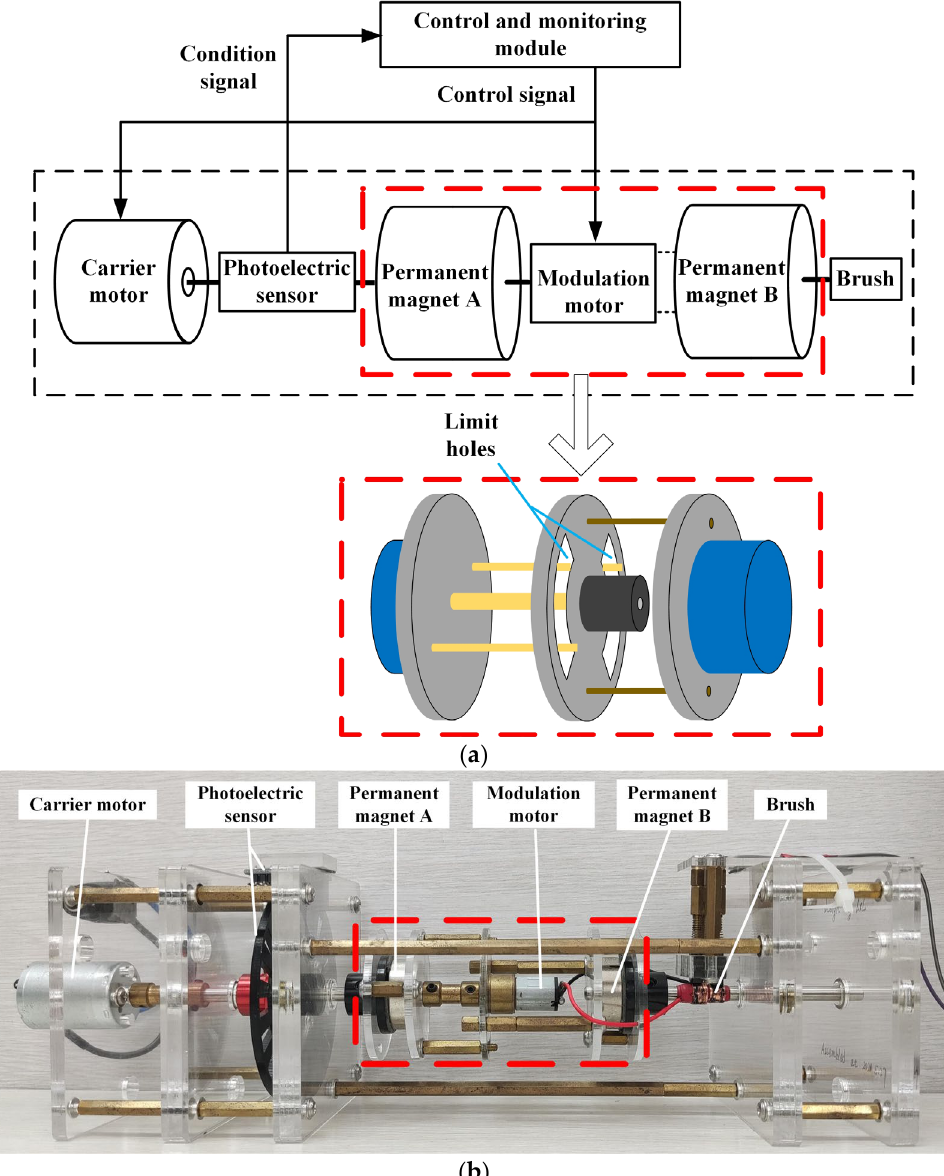
Figure 5. Dual-permanent-magnet mechanical antenna: ( a ) principle of the structure; ( b ) physical prototype.